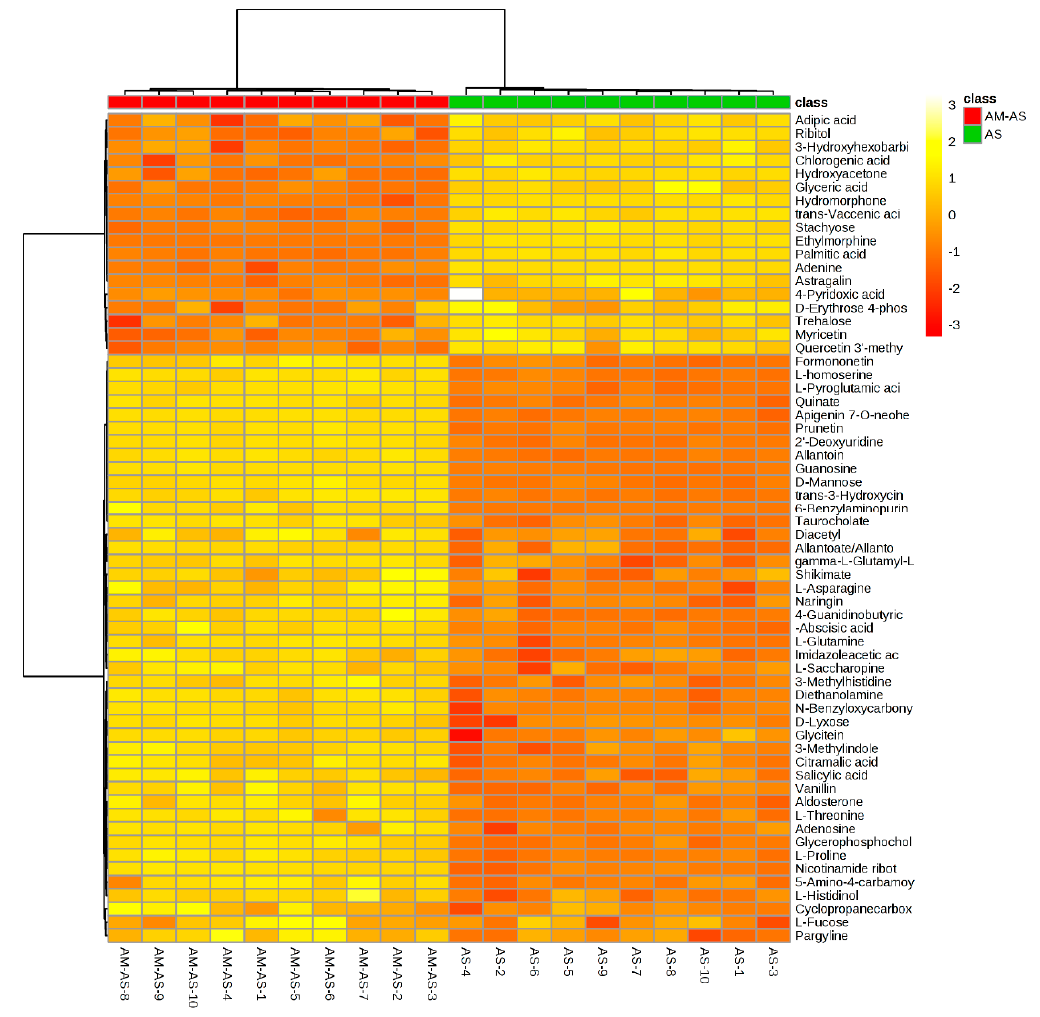
Figure 5. Heat map analysis combined with hierarchical cluster analysis in comparison between alkali stress with AM and only alkali stress treated seedlings of P. tenuiflora . AS: alkali stress without arbuscular mycorrhizal, AM-AS: alkali stress with arbuscular mycorrhizal.